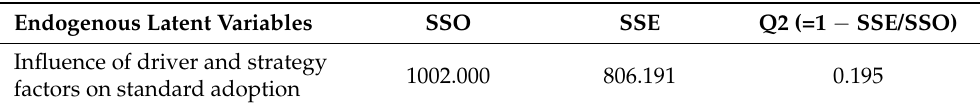
Table 10. Results of predictive relevance (Q 2 )